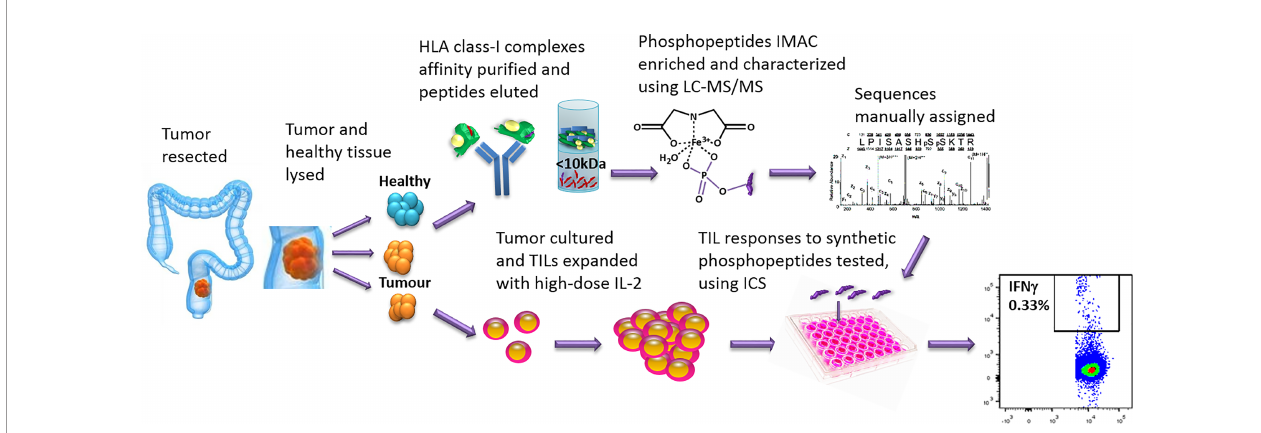
FIGURE 1 | The work- fl ow used to identify phosphopeptides from CRC tumors and to test TIL responses to the phosphopeptides identi fi ed. Tumor and neighboring healthy tissue samples were taken at resection. Some tumor was cultured and the TILs expanded, using high-dose IL-2. The remaining sample was homogenized in sample buffer and HLA-I complexes af fi nity puri fi ed with immobilized W6/32 antibody. The peptides were acid eluted, the phosphopeptides IMAC enriched and then characterized using LC-MS/MS. Synthetic phosphopeptides were used to test TIL responses to the phosphopeptides identi fi ed on the tumors using an intracellular cytokine staining